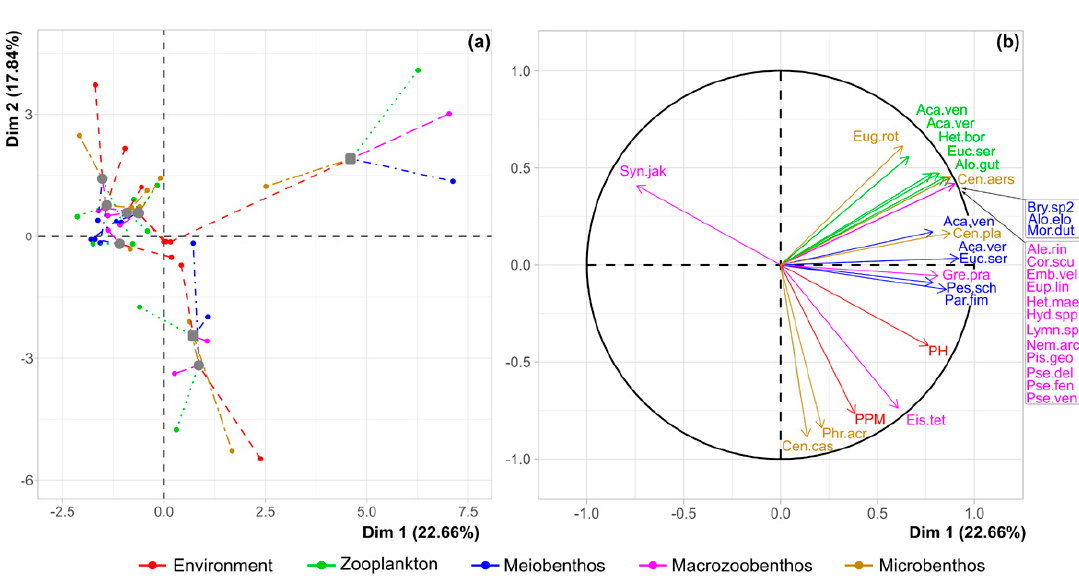
Figure 5. Multiple factor analysis (MFA) of the four assemblages (zooplankton and macro − , meio − and microbenthos) and environmental data sets (area, temperature, mineralization, pH and per- mafrost depth) from waterbodies of the Lena River Delta. ( a ) Sample ordination diagram (points projections of the five data sets onto MFA axes 1 and 2 connected by the lines to their centroid; circles are lakes, squares are polygonal ponds). Black circles, triangles and squares are centroids of the sample coordinates based on all five data sets. ( b ) Correlation circle map (for clarity, only variables with a score over cos 2 = 0.2 are